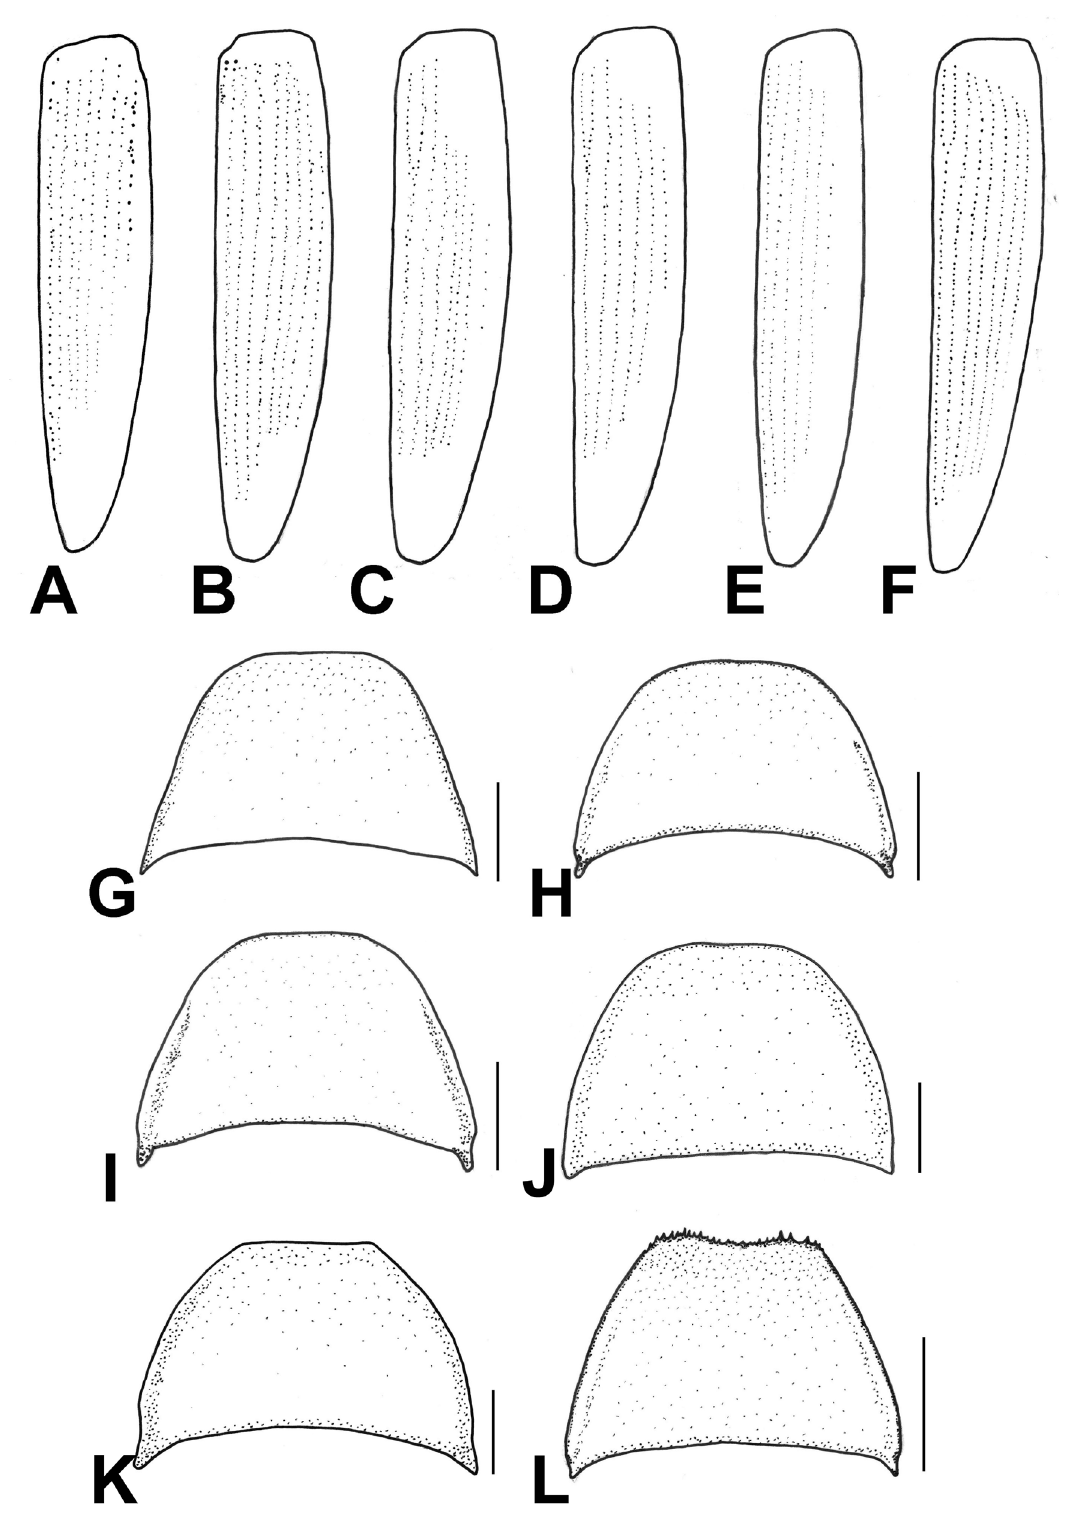
Fig. 4. Elytron and abdominal ventrite V. A–F . Elytron. G–L . Abdominal ventrite V of ♂♂. — A